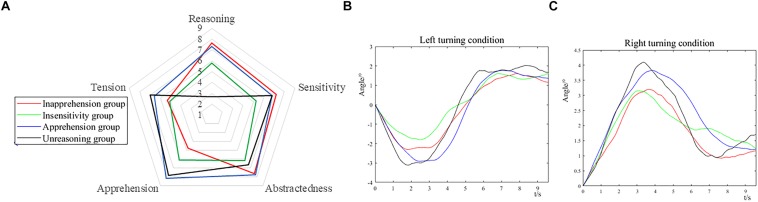
(A) Five selected personality traits of 16PF, averaged over subjects in each group. (B) The steering angle of the four groups under the left turning condition. (C) The steering angle of the four groups under the right turning condition. Decreasing angle corresponds to counterclockwise rotation, increasing angle corresponds to clockwise rotation.